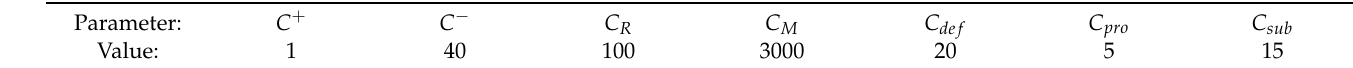
Table 3. Cost parameters.